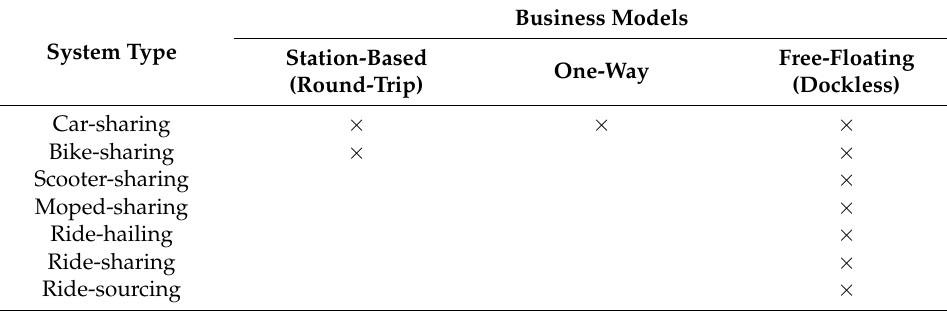
Table 1. Comparison of business models in new mobility systems.